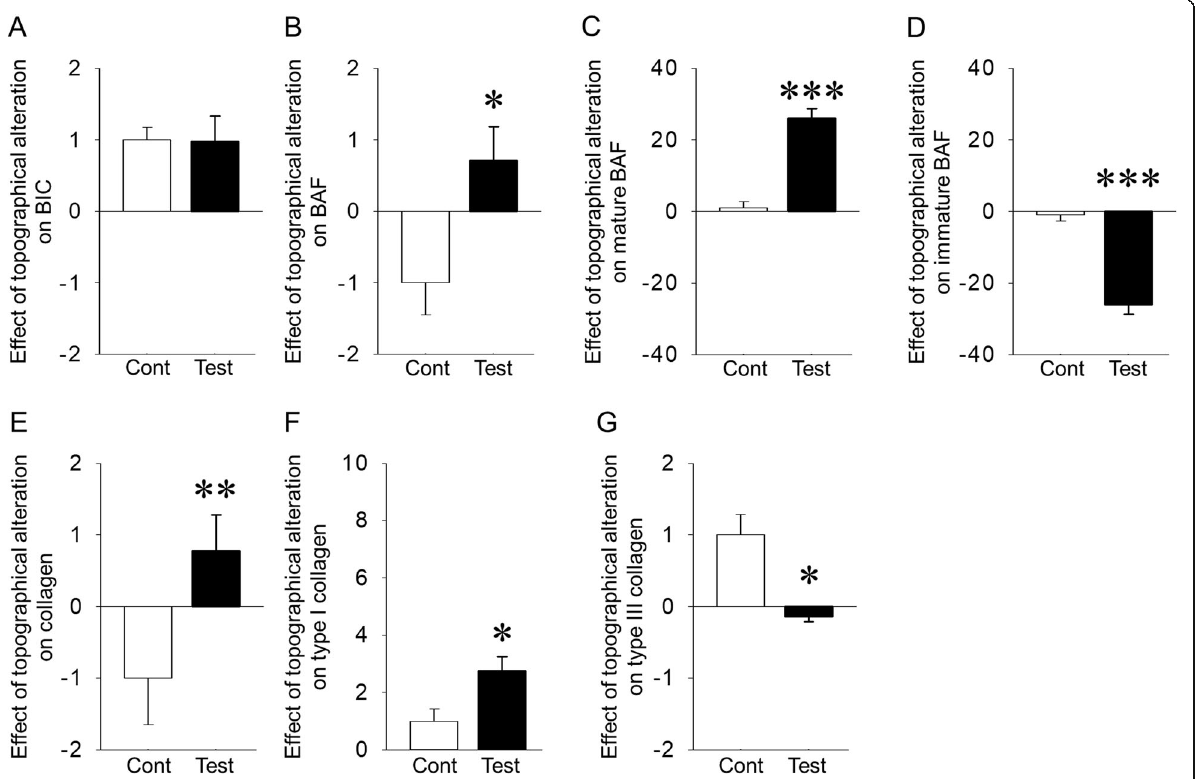
Fig. 5 a Same topographical effects on bone-to-implant contact (BIC) between groups (Cont: control). b Larger topographical effect on bone area fraction (BAF) in test implants when compared with controls. c , d Increased and decreased topographical effects on mature and immature BAF in test implants compared with controls, respectively. e Increased topographical effect on total collagen in test implants compared with control. f , g Increased and decreased topographical effects on type I and III collagen in test implants as compared with control. * p < 0.05, ** p < 0.01, *** p < 0.001, n = 7/each